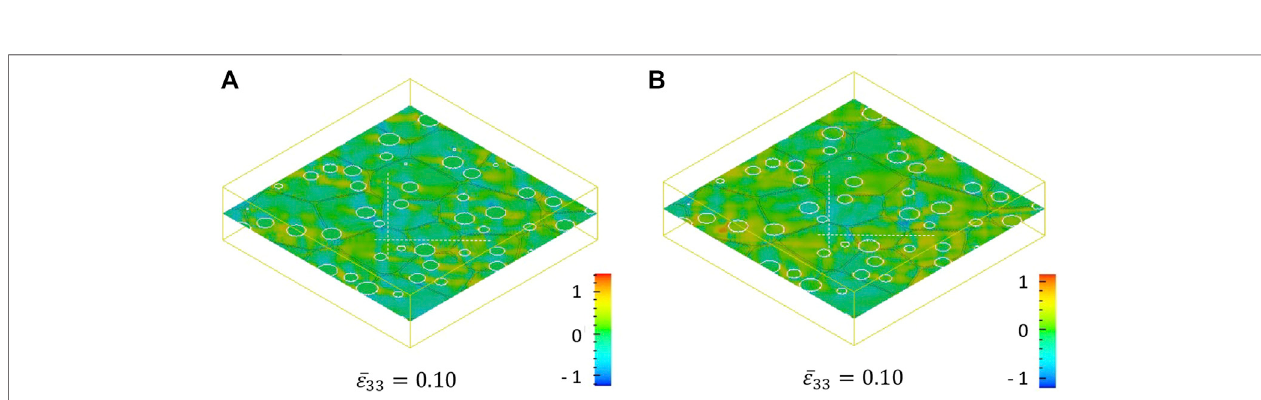
(cid:2) 0 . 07GPa and (B) gas bubbles with initial pressure P gb